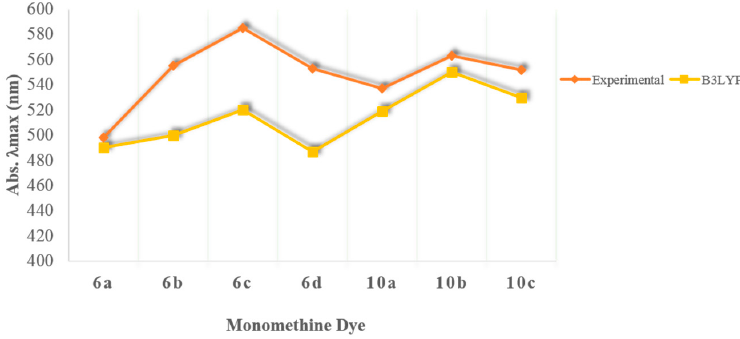
Figure 5. Experimental and Calculated λ max values.